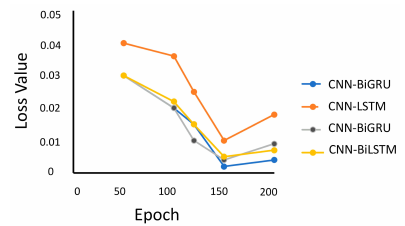
Figure 3. The loss value of the hybrid models.